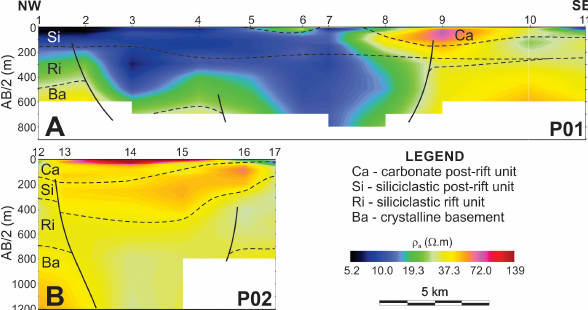
Figure 6. Interpreted apparent resistivity cross sections of profiles P01 (top) and P02 (bottom). VES locations: 1 to